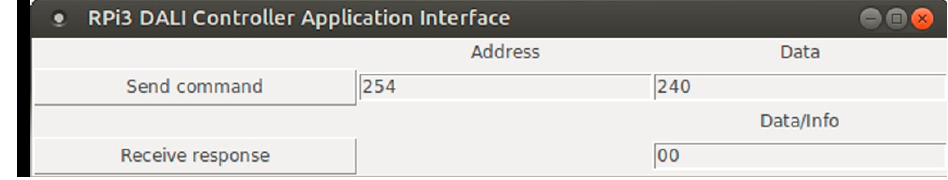
Figure 6. RPi3 DALI controller simple application interface.